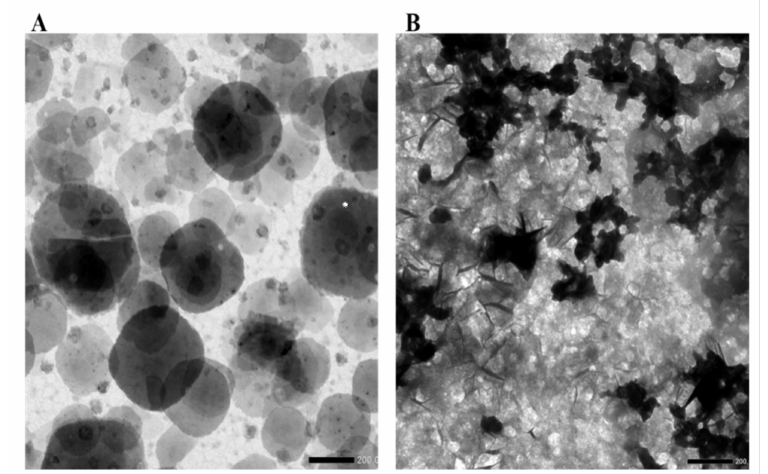
Figure 4. Transmission electron microscope image of ( A ) chitosan-TPP nanoparticles and ( B ) GnRH- loaded chitosan nanoparticles at a magnification × 20,000 and 25 ◦ C.